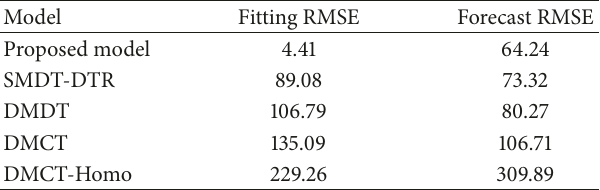
Figure 7: Reported cases of chickenpox from week 4, 2007, to week 3, 2012 (solid points), and the estimates obtained with the Bayesian stochastic SEIR model in discrete time proposed in this paper (solid lined), the stochastic model in discrete time with a deterministic seasonal transmission rate (dashed line) and the deterministic continuous-time model with a seasonal transmission rate and heterogeneous mixing (dotted line). Table 2: Fitting and forecast RMSE for the proposed model and four alternative formulations of the SEIR model: a stochastic model in discrete time with a deterministic seasonal transmission rate, a deterministic model in discrete time with a seasonal transmission rate, and two deterministic continuous-time formulations, one with heterogeneous and the other with homogeneous mixing of individuals.